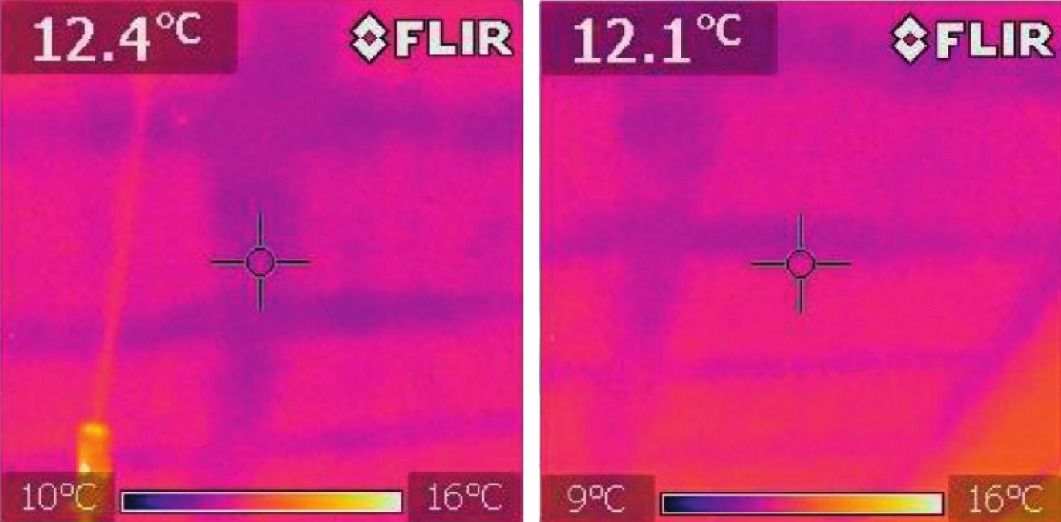
Figure 6: Thermo camera